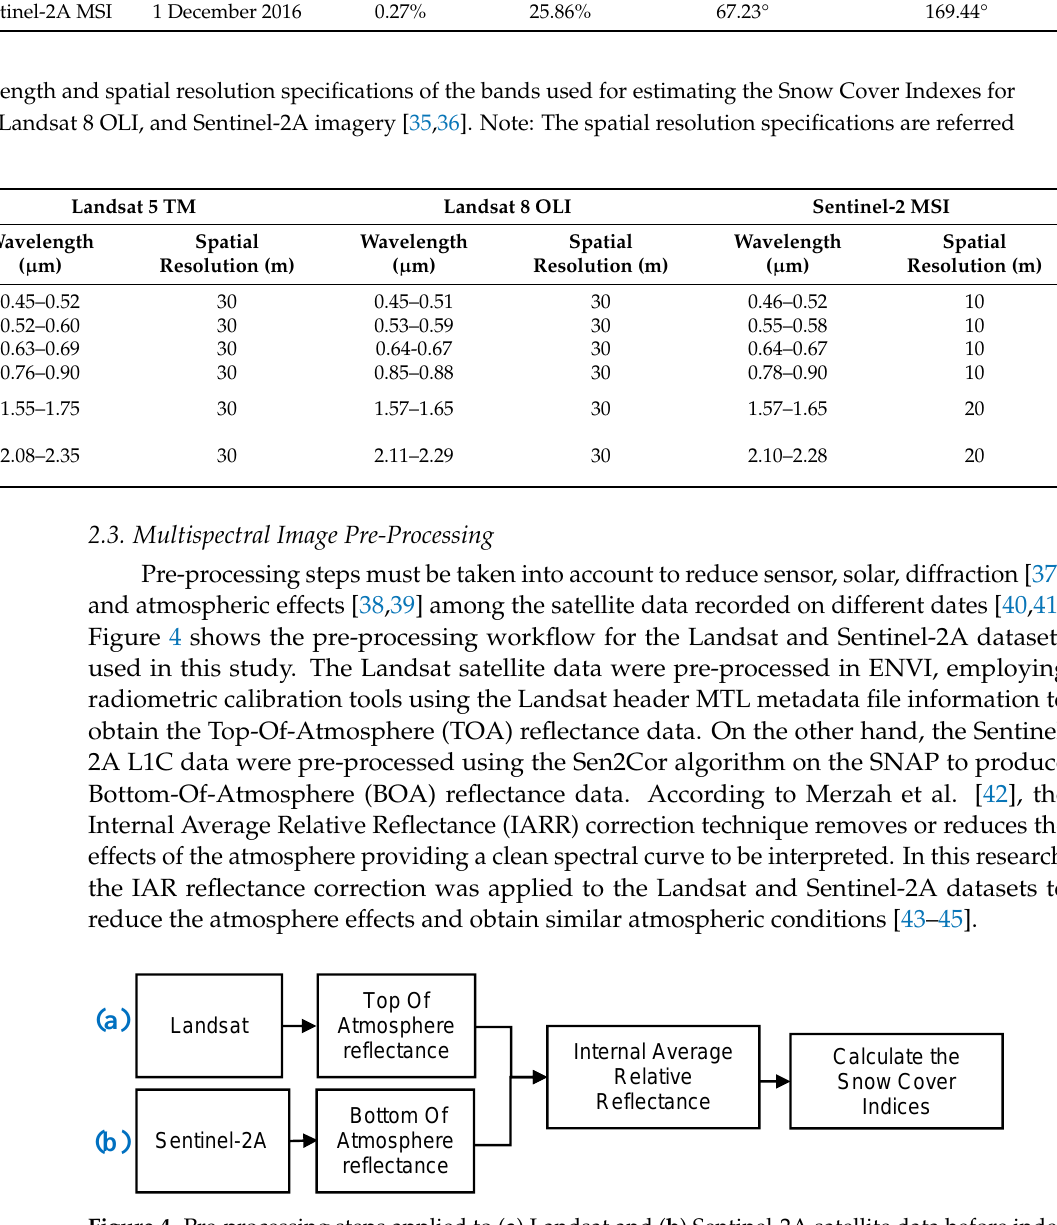
Figure 4. Pre-processing steps applied to ( a ) Landsat and ( b ) Sentinel-2A satellite data before index